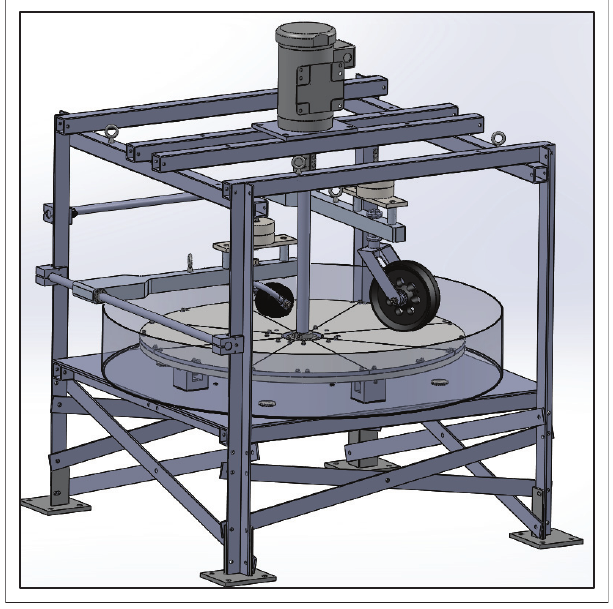
FIGURE 7: Turntable design concept.